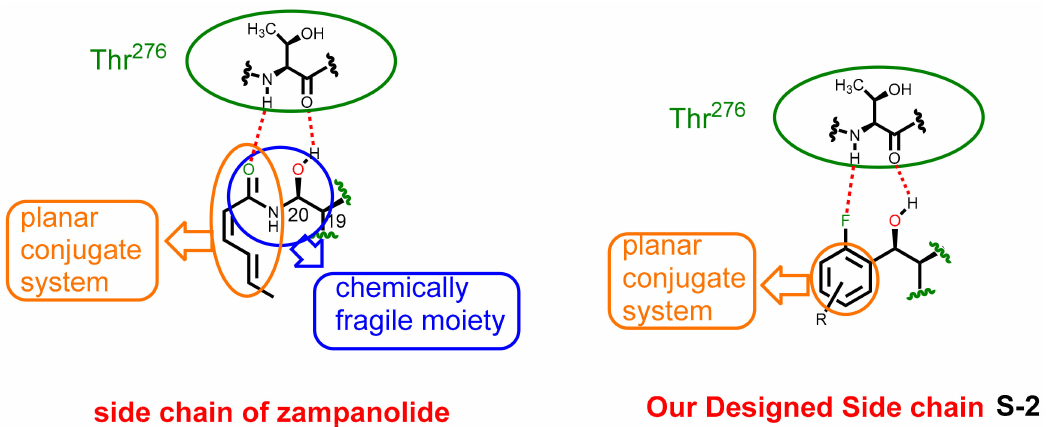
Figure 2. Design of a new stabilized side chain for zampanolide